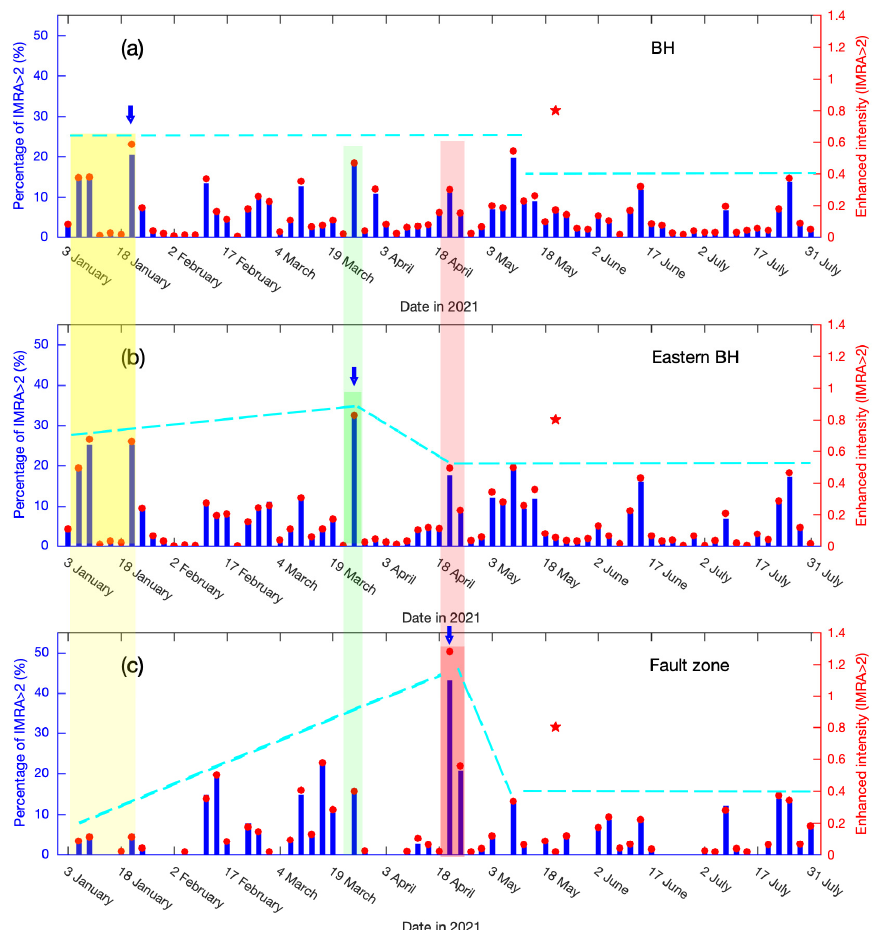
Figure 8. Time series of IMRA > 2 in the different scale tectonic units associated with the Madoi M7.3 earthquake: ( a ) Bayan Har tectonic block, ( b ) eastern Bayan Har tectonic block, and ( c ) seismogenic fault zone. Blue arrows indicate the maximum enhanced IMRA intensity in different tectonic units.